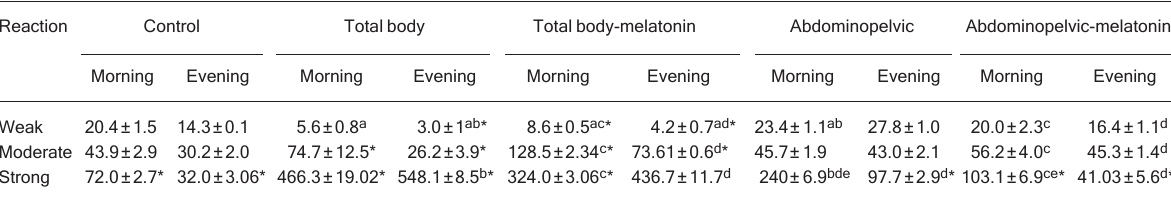
Table 2. Immunolabeling intensities of caspase-3 primary spermatocytes from the testes of all experimental groups. Reaction